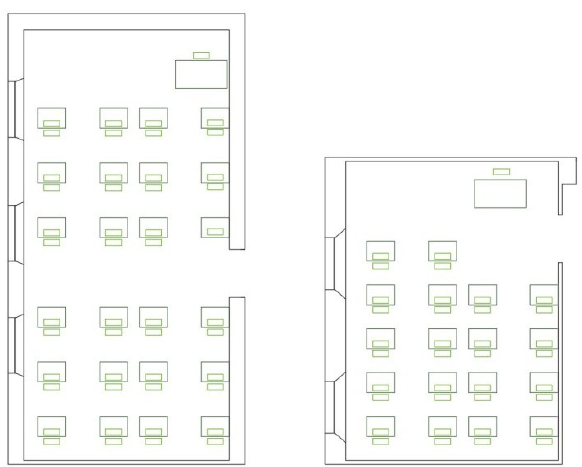
Figure 4. Application of option 3 in classrooms A (left) and B